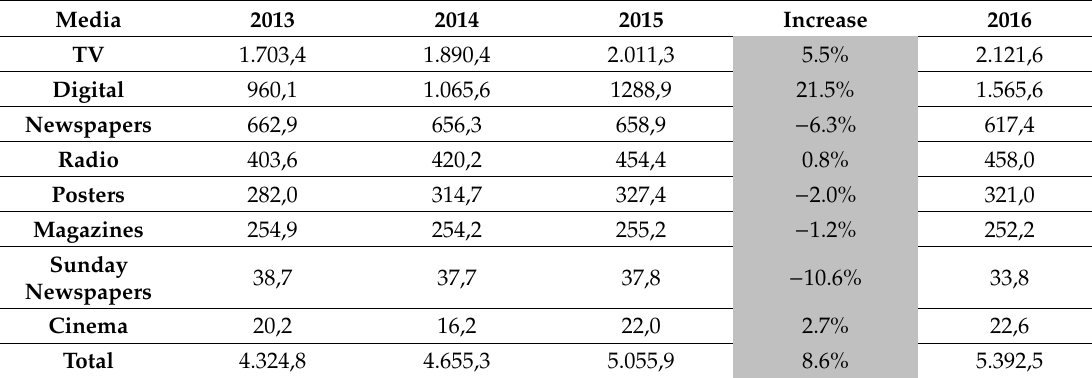
Table 1. Advertising